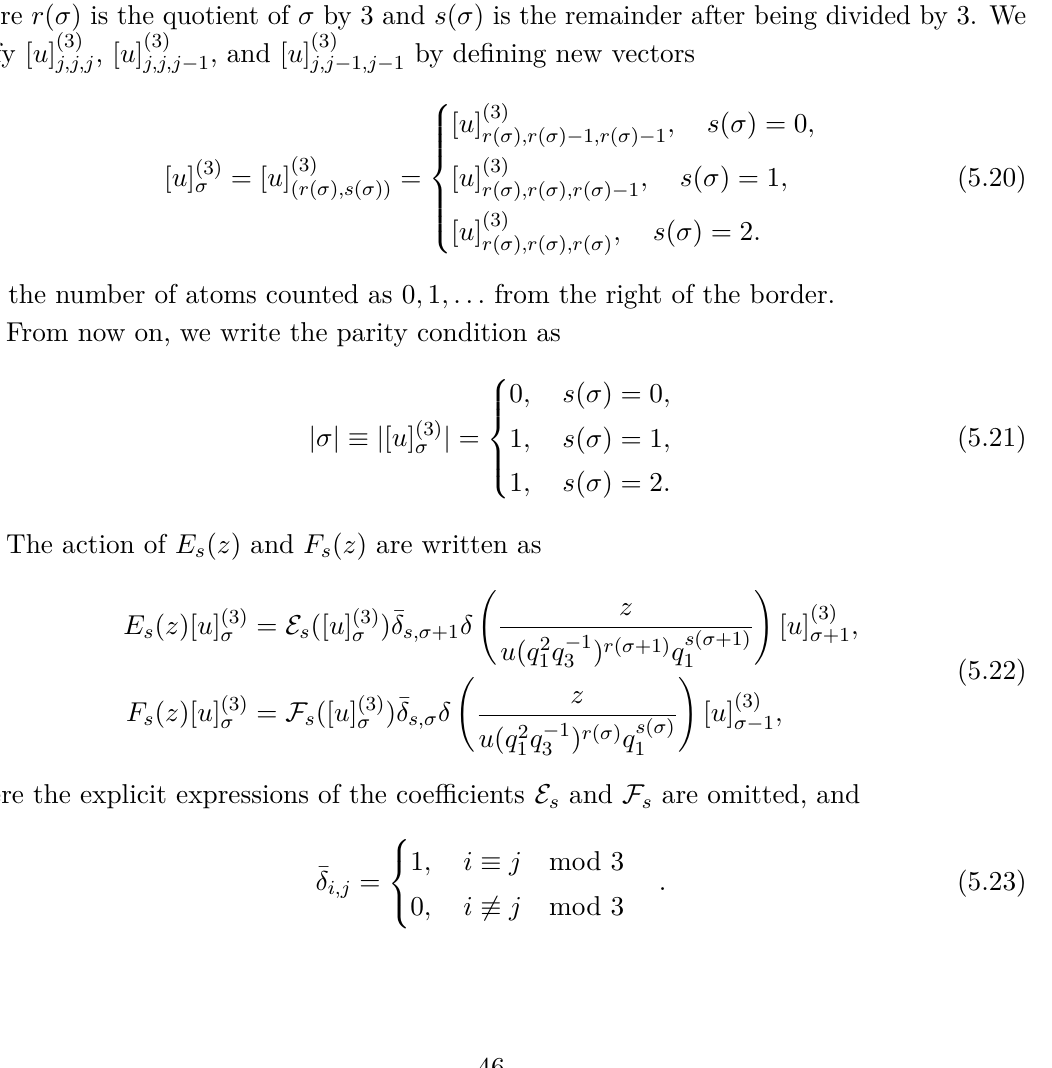
Figure 36. Generalization of Young diagram and correspondence with vectors for one-dimensional crystal ‘ . The generalized partition is expressed by two numbers ( λ − 1 , τ ) ∈ Z × Z 1 set τ ∈ Z = { 0 , 1 , 2 } . Using (5.20), it can be written as σ = 3 λ − 3 + τ , r (3 λ − 3 + τ ) = λ − 1 , and 3 s (3 λ − 3 + τ ) = τ